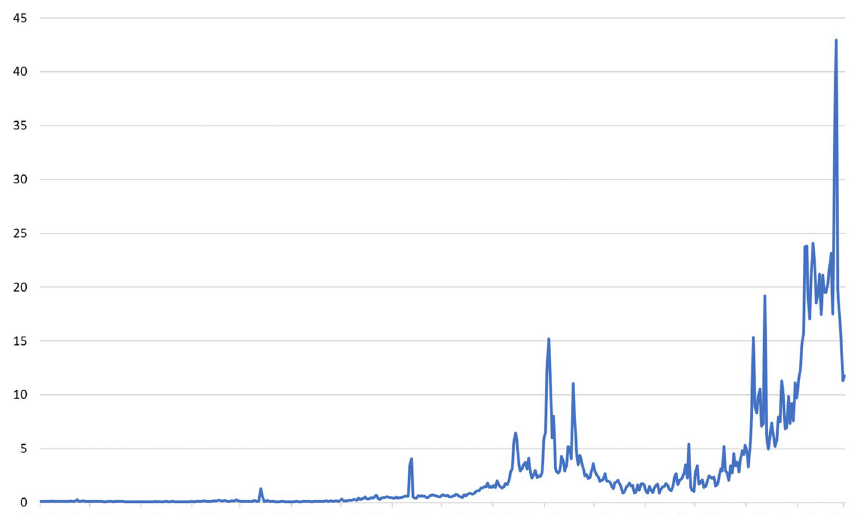
Fig. 9 Transactions costs on Ethereum in USD. Source : https:// block chair. com/ ether eum/ charts/ avera ge- trans action- fee-